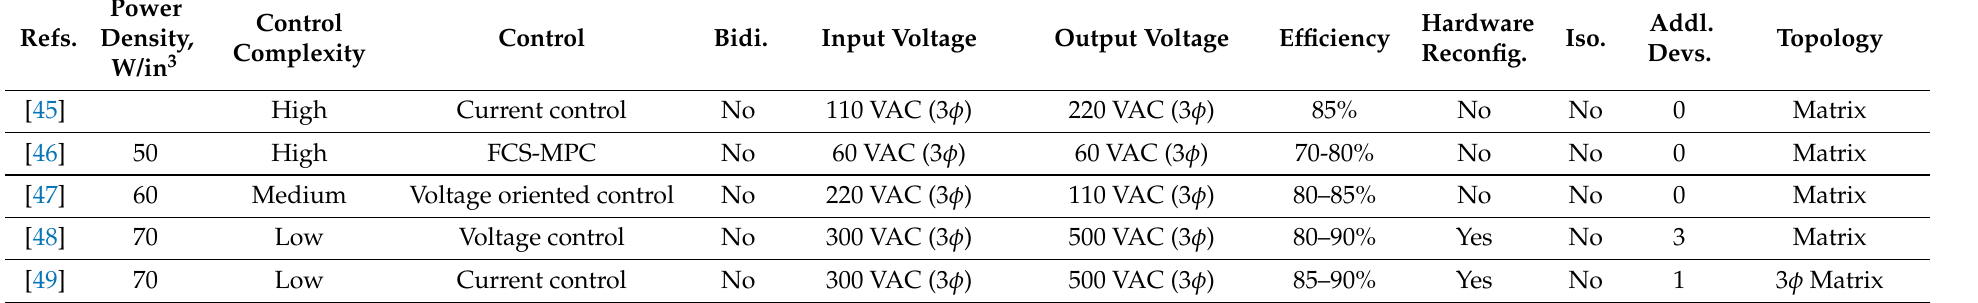
Table 3. Comparison of the different fault-tolerant module-level techniques.